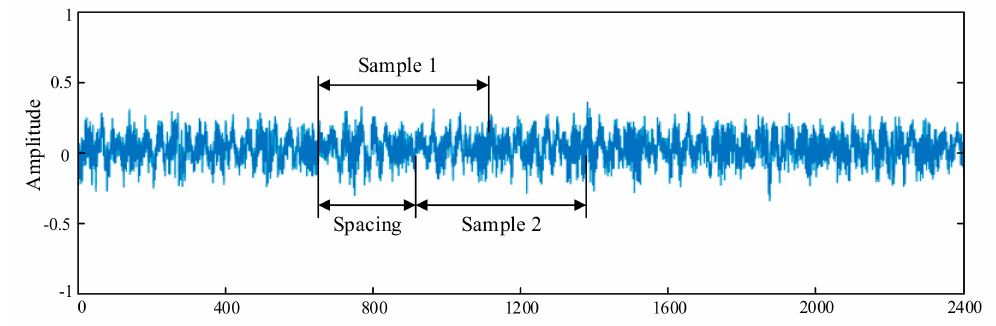
Figure 4. The method of data augment.